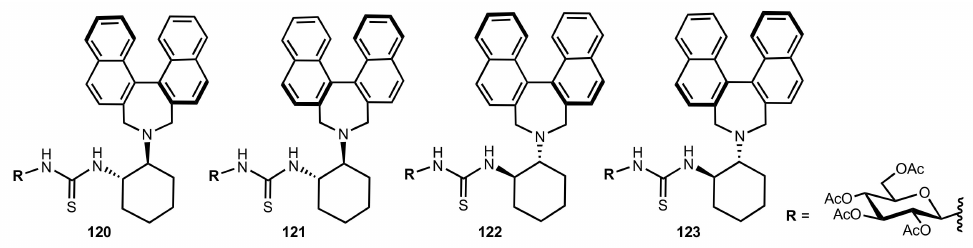
Figure 14. The structure of organocatalysts 120–123 . Compound 120 featuring the ( S , S )-diamine part and ( R )-configured binaphthyl